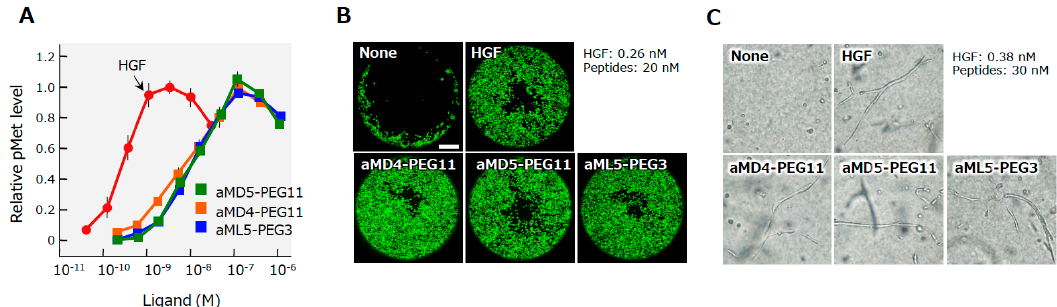
Figure 7. Structures and outline of the activity of a synthetic MET agonist composed of cyclic peptides [25].